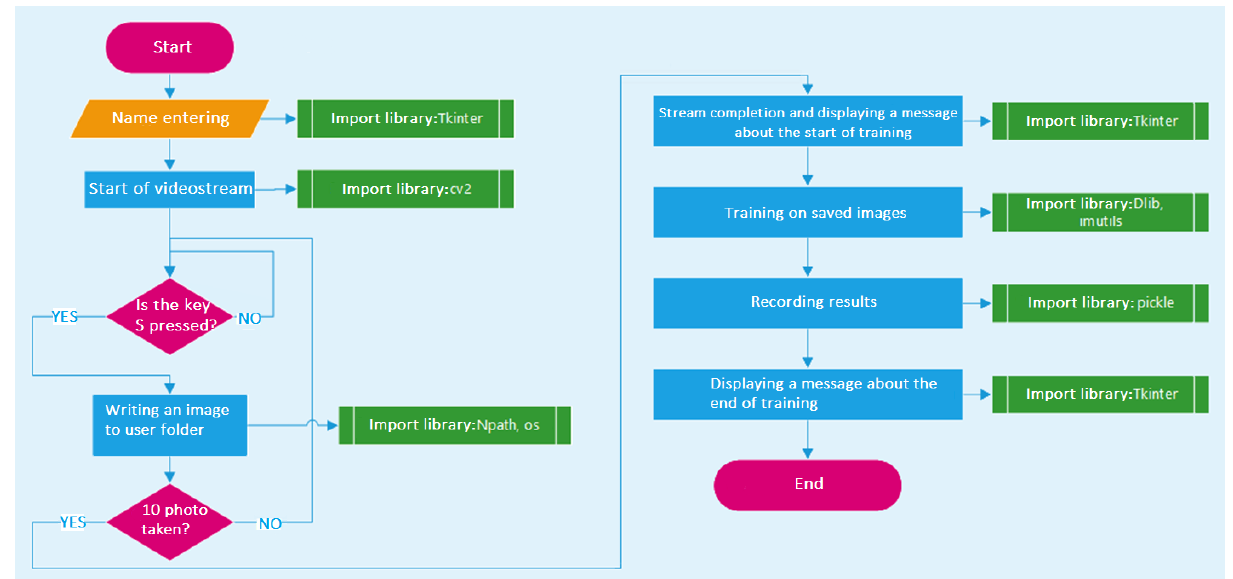
Figure 1. Work scheme of the data set creation script.